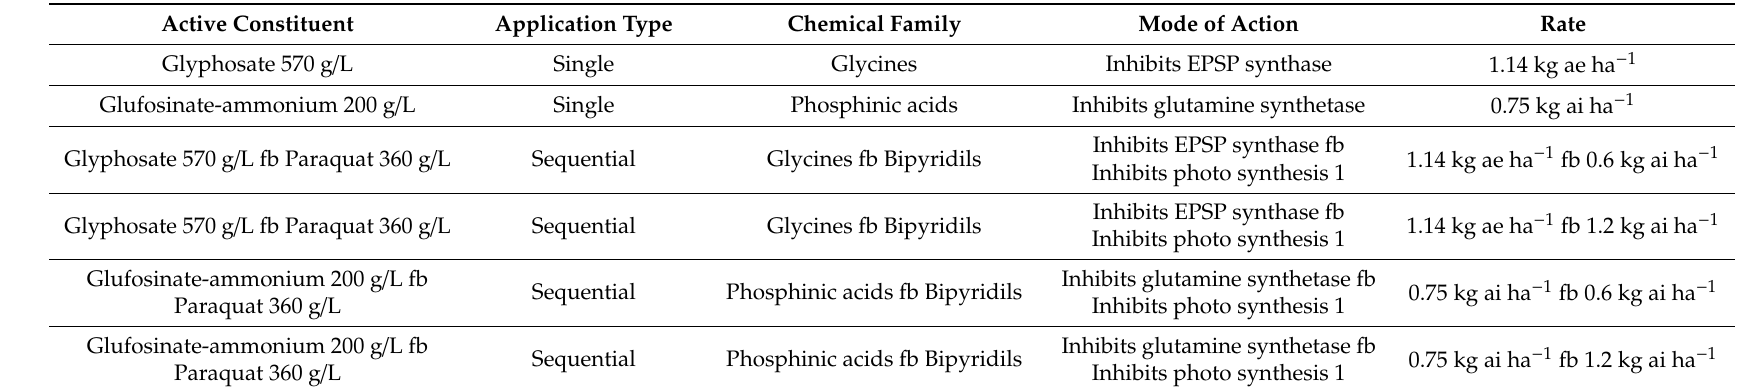
Table 3. Single and sequential herbicide treatments for the double knock